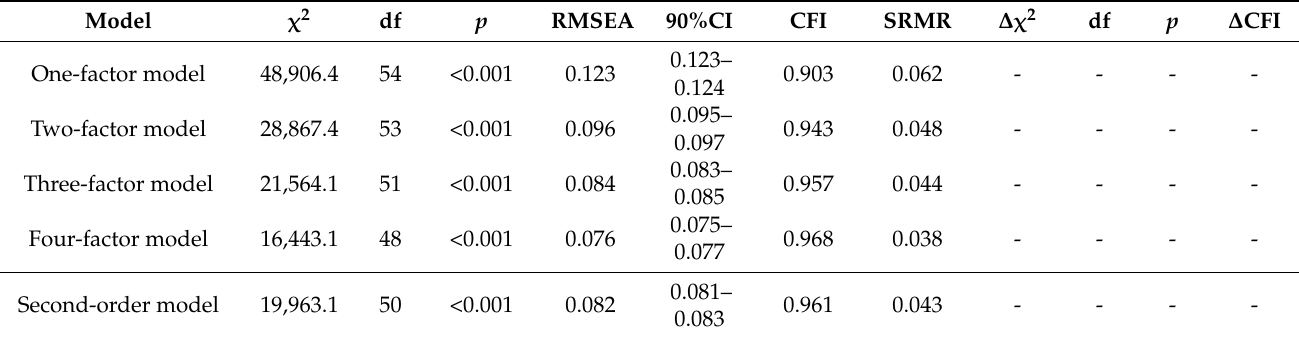
Table 1. Goodness-of-fit indexes for the five CFAs and the measurement invariance routine.